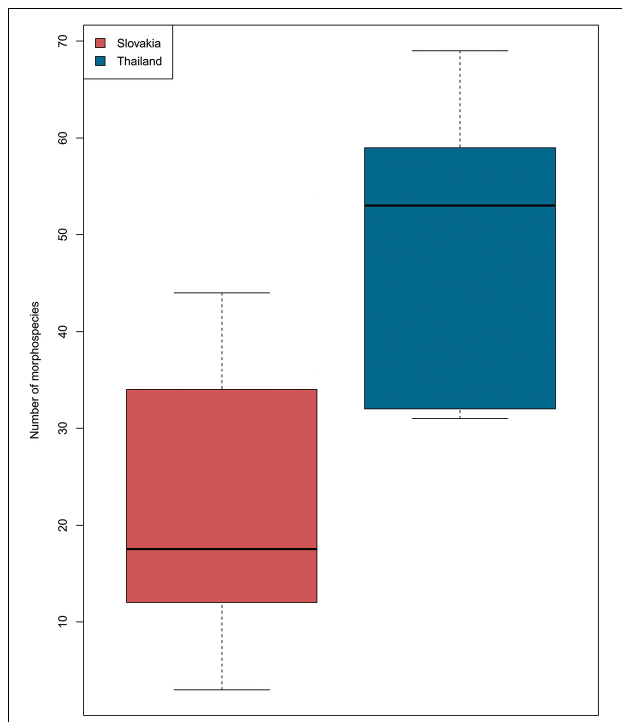
FIGURE 6 | Boxplot indicates the number of morphotaxa for Slovakia (red) and Thailand (blue). Kruskal–Wallis chi-squared = 5.4857, df = 1, p -value =